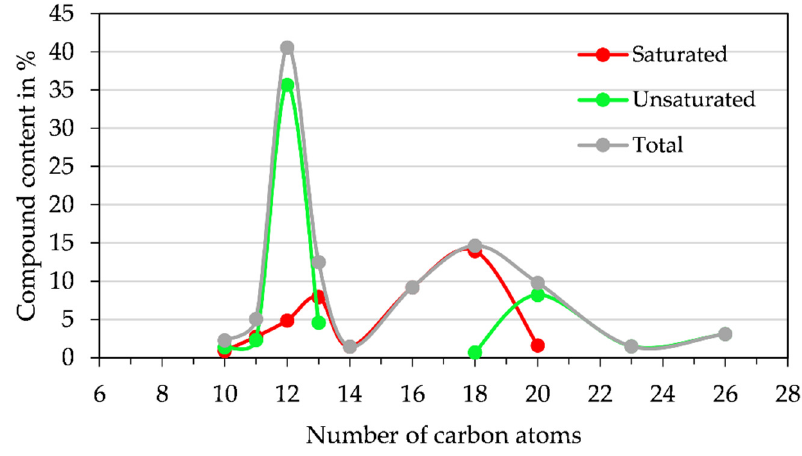
Figure 5. Percentage of compounds in PP pyrolysis oil and their carbon number (total compound content—grey, saturated compound content—red, unsaturated compound content—green).